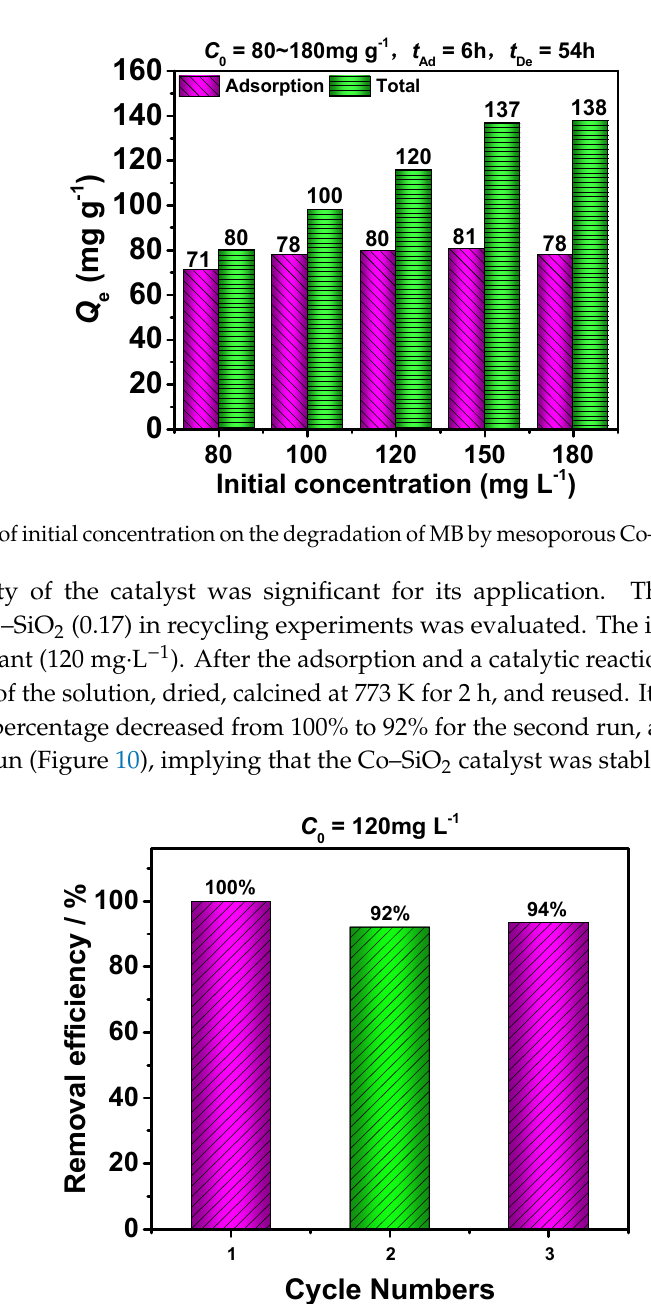
Figure 10. Recycling ability of the Co–SiO 2 (0.17) catalyst.